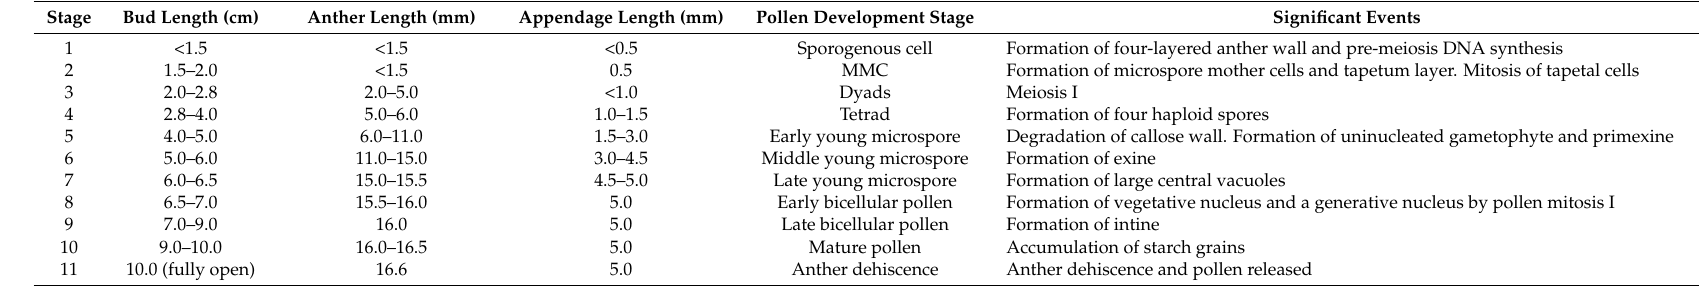
Table 1. Detailed description of the anther and pollen developmental stages of N. nucifera ‘Honghu